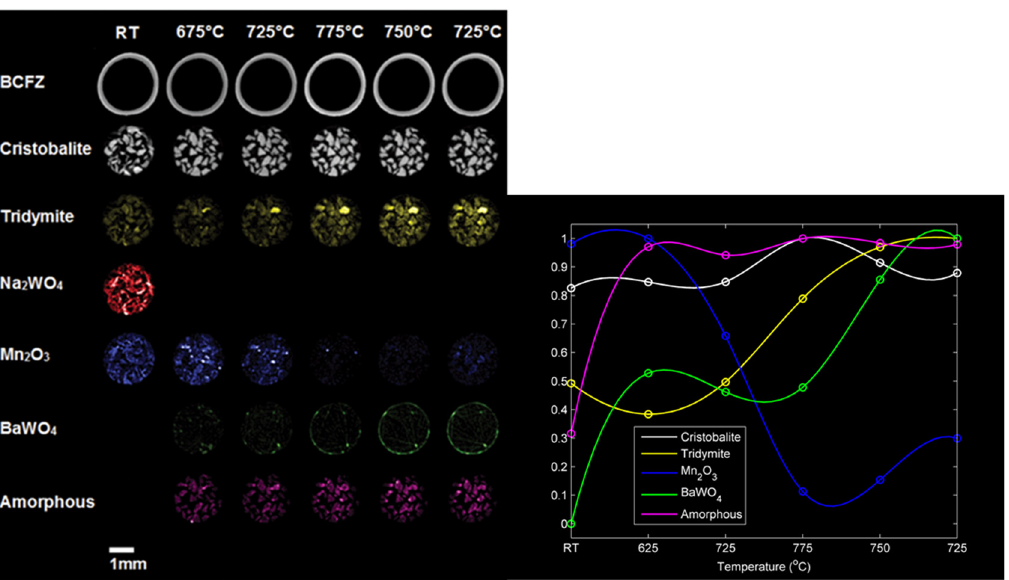
Figure 24. Phase maps obtained from the X ‐ Ray diffraction computed tomography (XRD ‐ CT) data (integrated intensities) of the BaCo x Fe y Zr z O 3 ‐δ BCFZ membrane phase and the catalyst phases: cristobalite and tridymite (SiO 2 polymorphs), Na 2 WO 4 , Mn 2 O 3 , Ba 2 WO 4, and an amorphous phase [28].